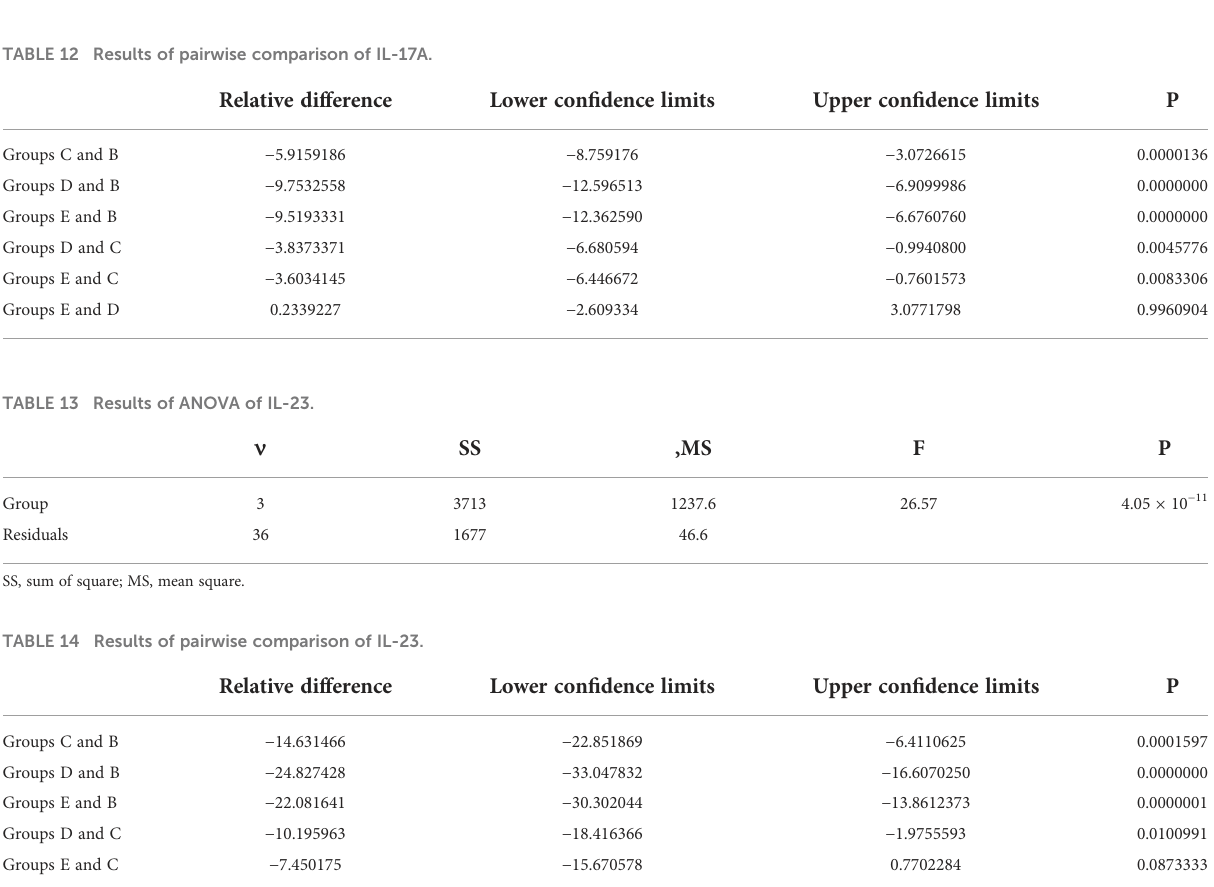
signi fi cant differences existed between the other two groups (Table 12). No difference was observed between the indirubin group and the combined group, and the indirubin group was superior to the stem cell group.